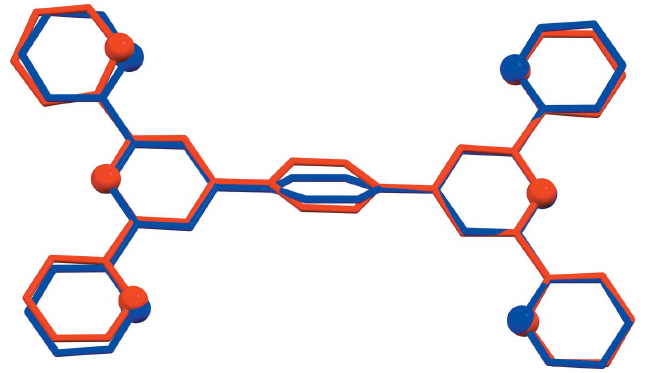
Figure 2 A structural overlay of the title triclinic polymorph (Form I; blue) and the orthorhombic polymorph (Form II; red), drawn using Mercury (Macrae et al. , 2008).